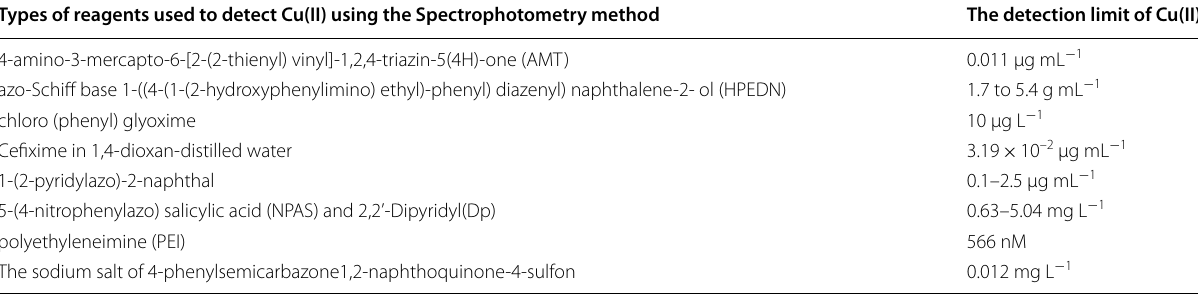
Table 3 Types of reagents used in Cu(II) spectrophotometry detection method Types of reagents used to detect Cu(II) using the Spectrophotometry method